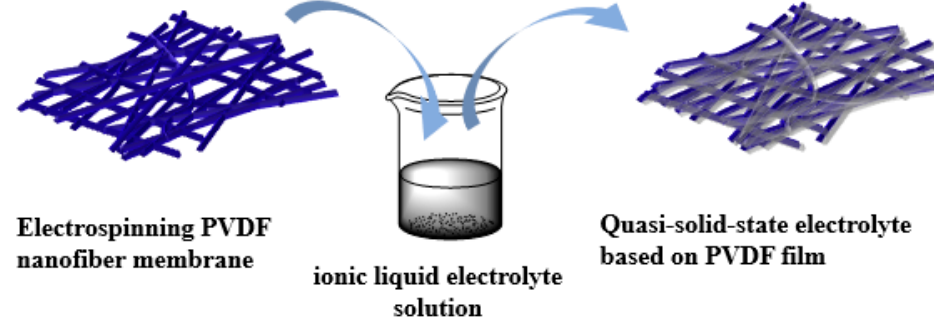
Figure 2. Schematic showing the process steps in the preparation of the quasi-solid-state electrolyte.